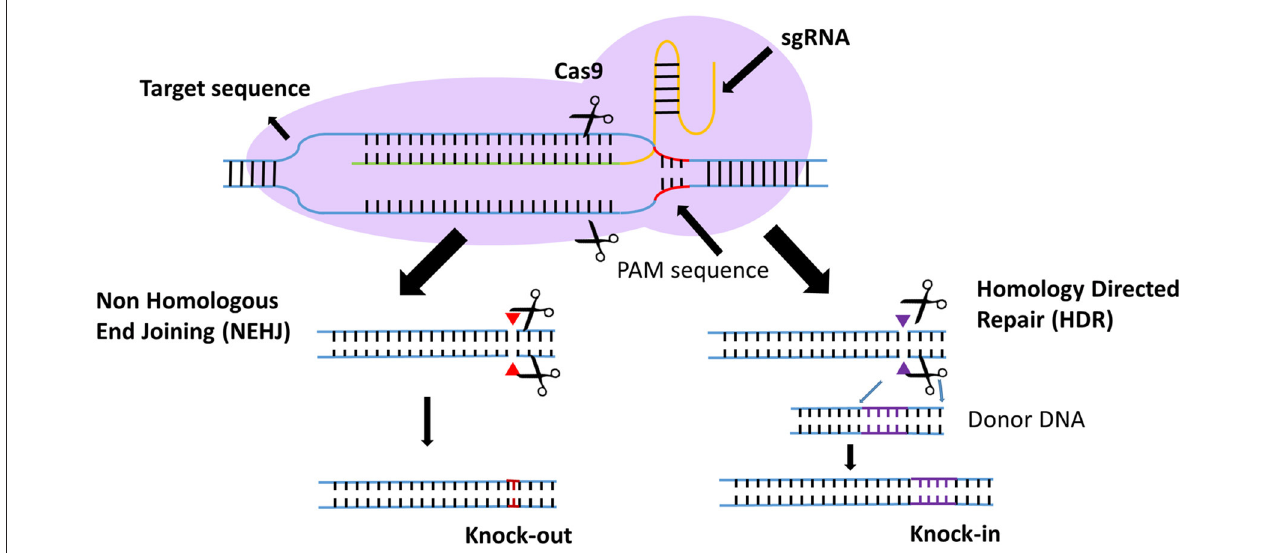
FIGURE 2 | Introduction to the CRISPR gene-editing system. Guided by sgRNAs, the CRISPR-Cas9 nuclease can target short DNA sequences. The PAM specifically creates a sgRNA–target DNA heteroduplex and generates double-strand breaks. Then, the DNA double-strand breaks are repaired by non-homologous end-joining (NHEJ) or homology-directed repair (HDR). In the NHEJ pathway, indels lead to nucleotide deletions or insertions. In the HDR pathway, accessory factors can facilitate genome recombination through the two homology arms, resulting in the knock-in of a gene of